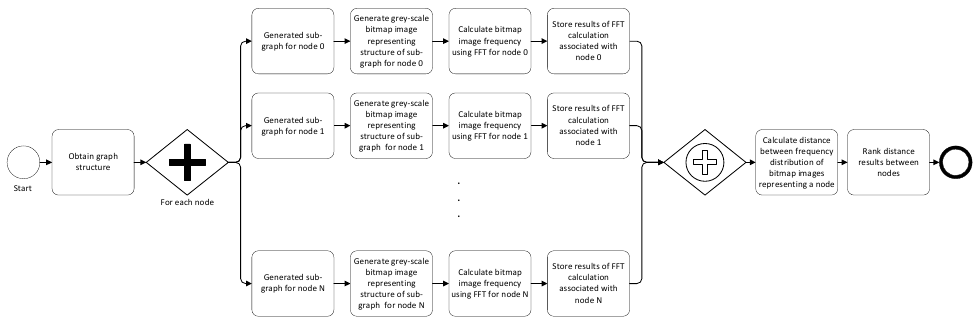
Figure 3. The visual representation of the proposed algorithm flow using BPMN.